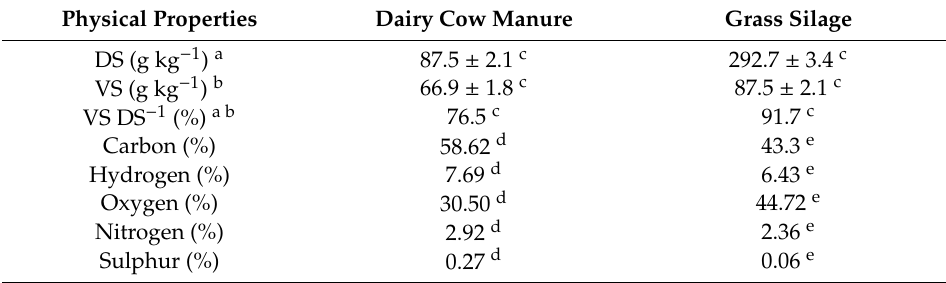
Table 4. Physical and chemical properties for dairy cow slurry and grass silage. Physical Properties Dairy Cow